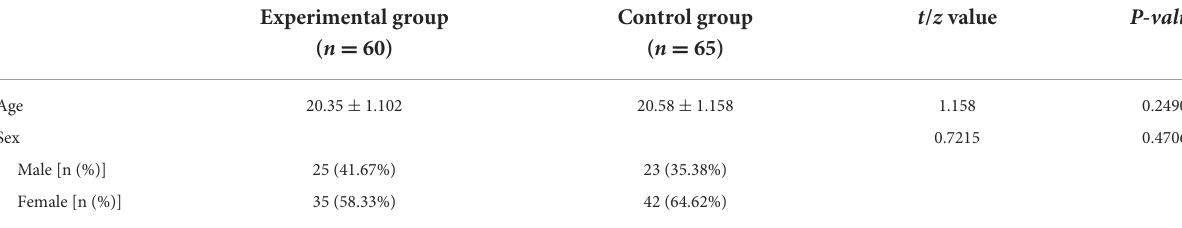
TABLE 1 Basic information of the two student groups.